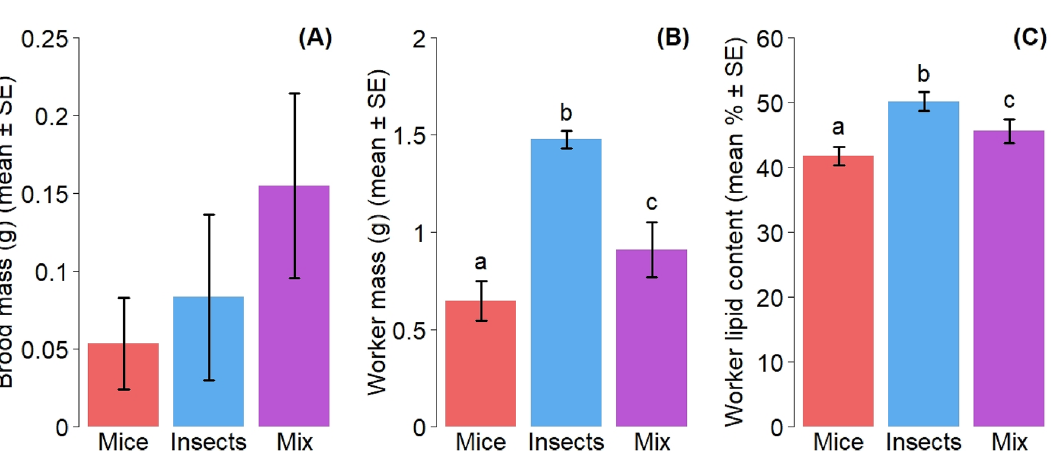
Figure 3. ( A ) Final brood mass of experimental colonies (mean ± SE), ( B ) final worker mass of experimental colonies (mean ± SE) and ( C ) proportion of lipids per ant (mean ± SE) as a functions of food treatments. Red = mice (n = 6), blue = insect (n = 5), purple = mix (n =